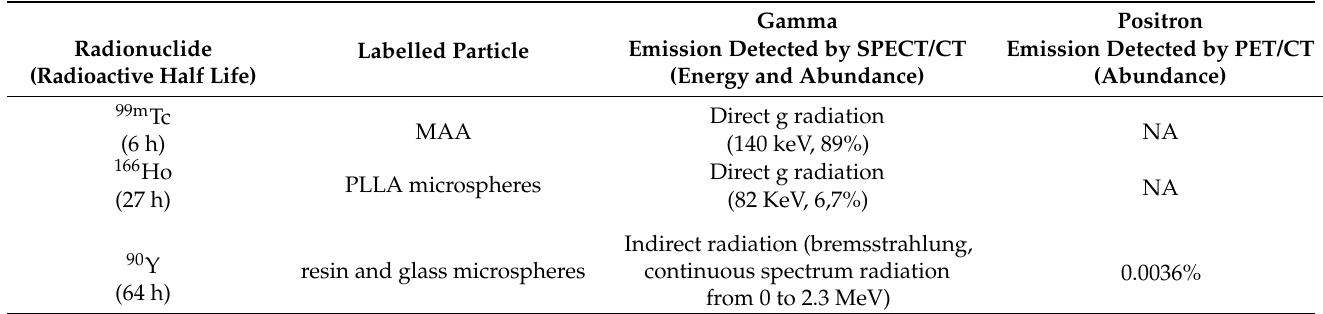
Table 1. Radiation emission characteristics of radiolabeled microspheres and MAA detected by nuclear imaging systems.